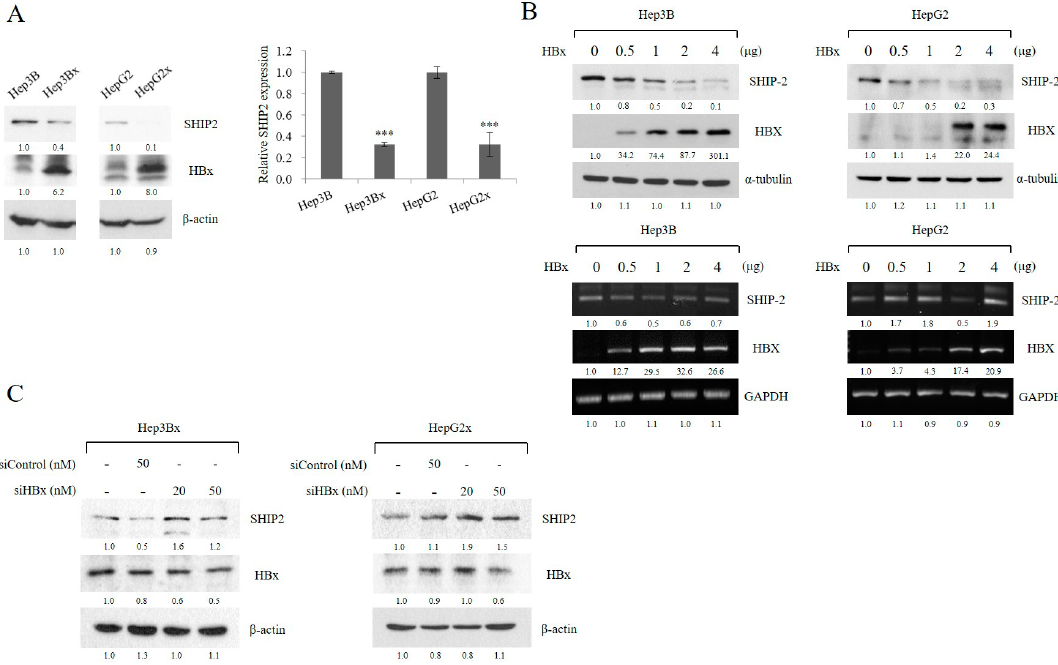
Figure 2. Hepatitis B virus (HBV)–encoded X protein (HBx) reduces SHIP2 protein expression in HCC cells. ( A ) SHIP2 was reduced in HBx-expressing Hep3Bx and HepG2x HCC cell lines, as compared with parental lines. Quantification of relative SHIP2 expression is shown ( n = 3). Data represent the mean ± s.d., *** p < 0.001. ( B ) HBx expression vector was transiently transfected into Hep3B and HepG2 cell lines for 48 h. SHIP2 and HBx expression was analyzed at the protein level by western blotting and at the mRNA level by RT-PCR. ( C ) Transient transfection of HBx and control siRNA was performed in Hep3Bx and HepG2x cells for three days. SHIP2 expression and gene silencing of HBx protein expression were examined by western blotting. In all the above cases, α -tubulin, GAPDH (Glyceraldehyde 3-phosphate dehydrogenase), and β -actin are used as the internal control. The whole blot has been provided as Supplemental Materials (Figure S4).